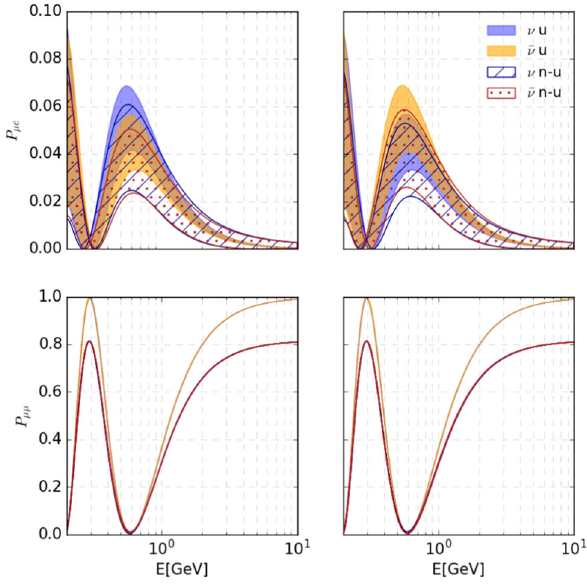
Fig. 2 Same as Fig. 1 but for the T2K experiment (295 km